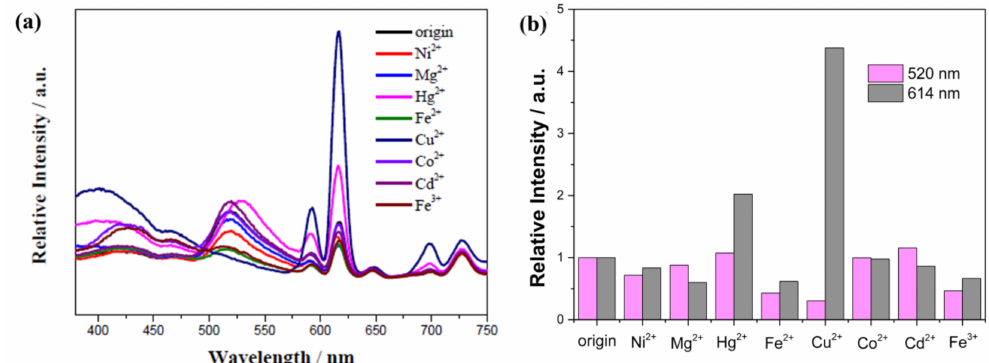
Figure 2. ( a ) PL spectra of FAM-ssDNA and Eu 3+ @Bio-MOF-1 dispersed into aqueous solutions of various metal ions with the concentration of 10 − 5 mol/L when excited at 323 nm; ( b ) Relative luminescence intensity of FAM at 520 nm and Eu 3+ at 614 nm. Reprinted with permission from [69]. Copyright 2017 Elsevier B.V., New York, NY,